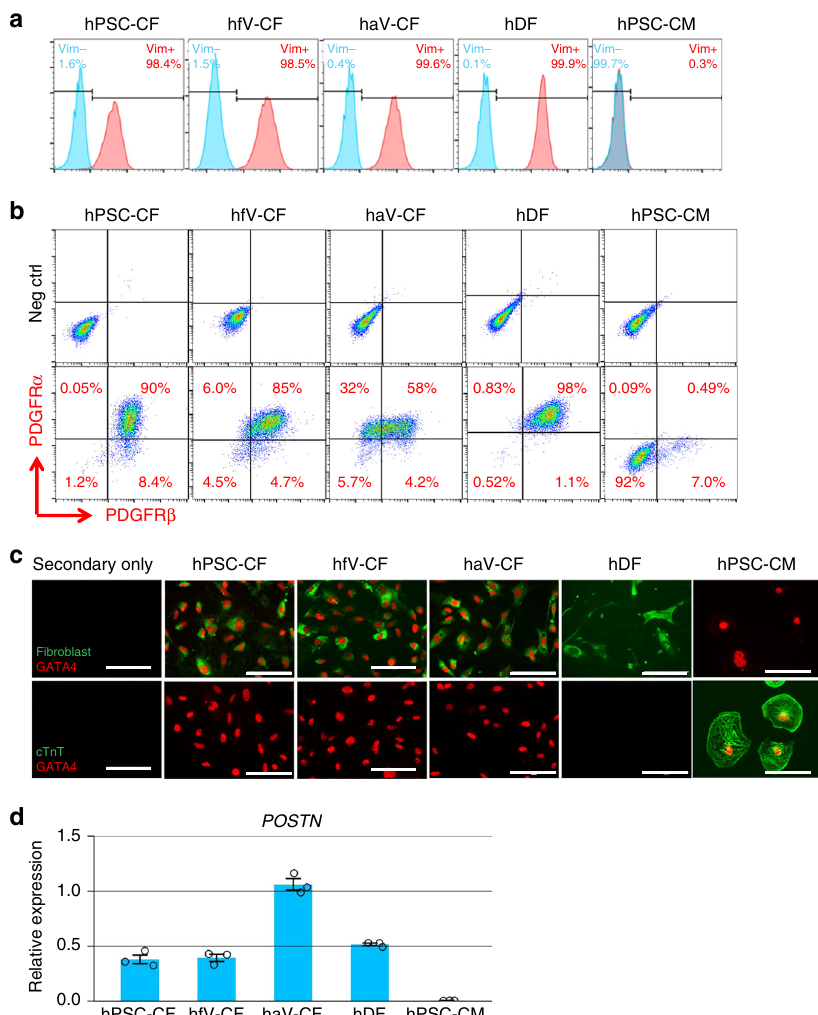
Fig. 6 Representative markers expression in CF, DF and hPSC-CM. a Histogram plot of fl ow cytometry analysis for vimentin. b Flow cytometry analysis of co-labeling for PDGFR α and PDGFR β . c Immunolabeling by antibodies for fi broblast (clone TE-7), cTnT and GATA4. d POSTN expression examined by qRT- PCR ( n = 3 technical replicates). Data are mean ± SEM. Scale bars are 100 μ m. All fi broblasts samples used in the measurement are from passages 3 to 7. The hPSCs are DF19-9-11T hiPSCs. The primary hfV-CFs are from Cell Applications, Inc. The haV-CFs are from Lonza, NHCF-V. The hDF line is from